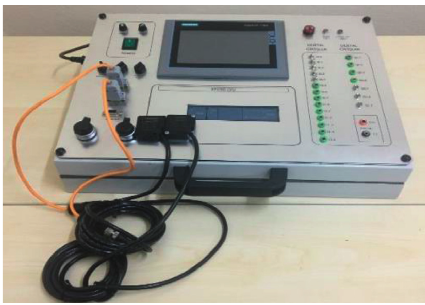
Figure 3: View of the designed